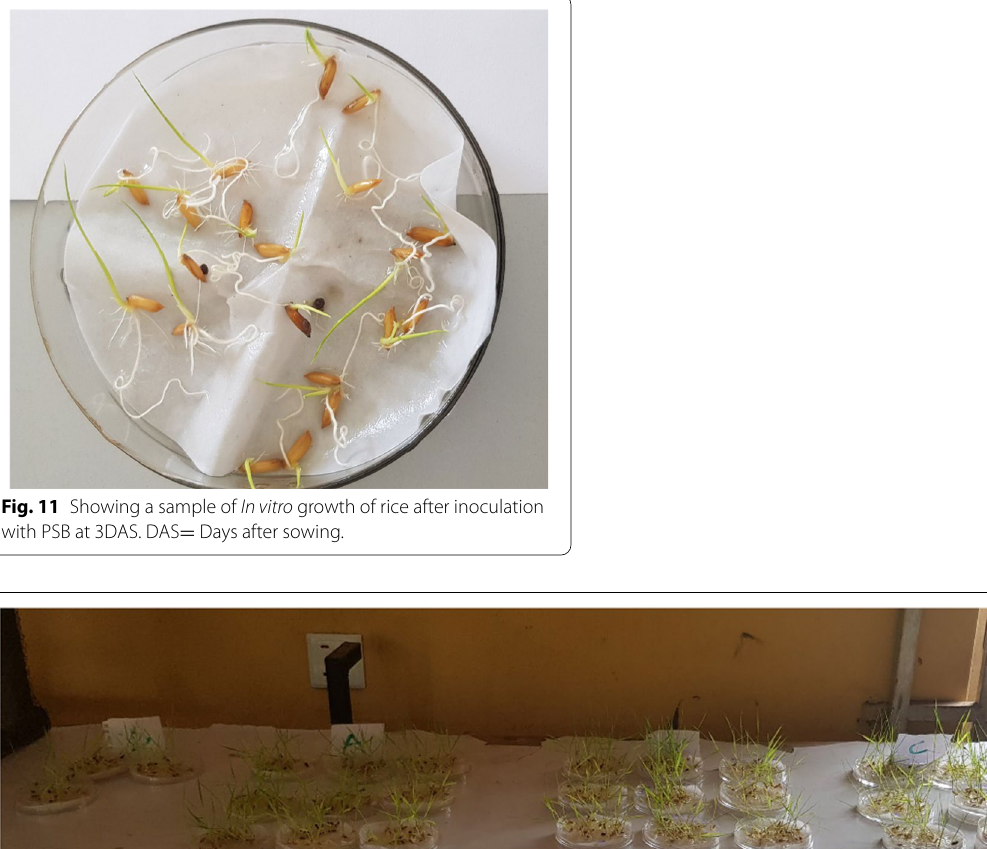
Bacillus sp., B Proteus sp., C Klebsiella = = =